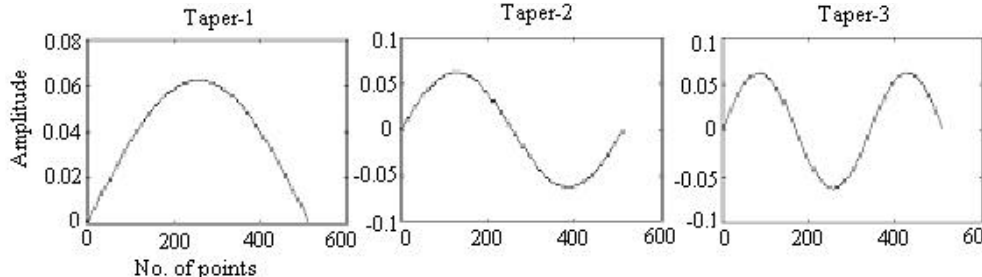
Fig. 1. Time domain representation of the first 3 orders of sinusoidal taper.